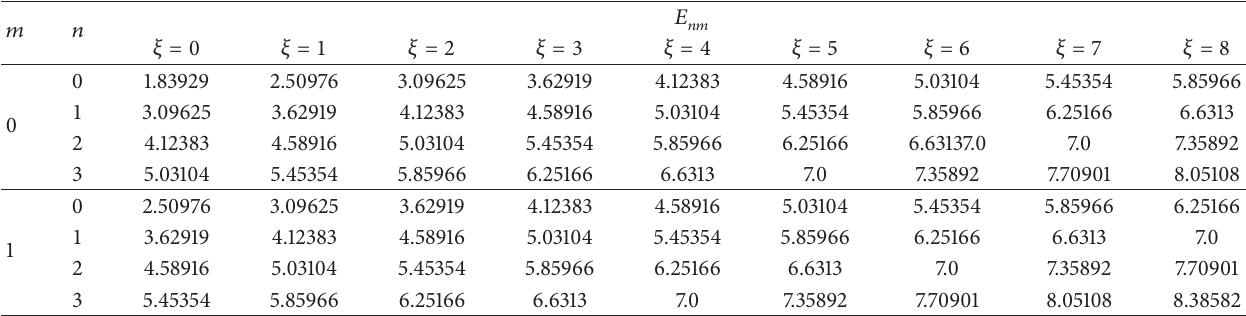
Table 2: The KG energy eigenvalues ( 𝐸 𝑛𝑚 in atomic units) of the harmonic oscillator potential for various 𝜉 values and 𝜔 𝐿 = 0 . 𝑚